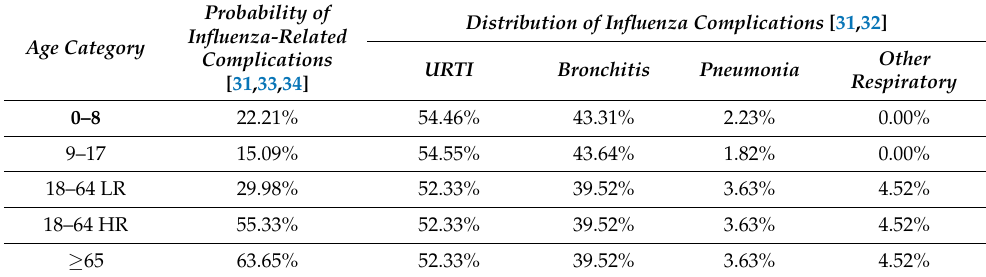
Table 7. Influenza-related complications.